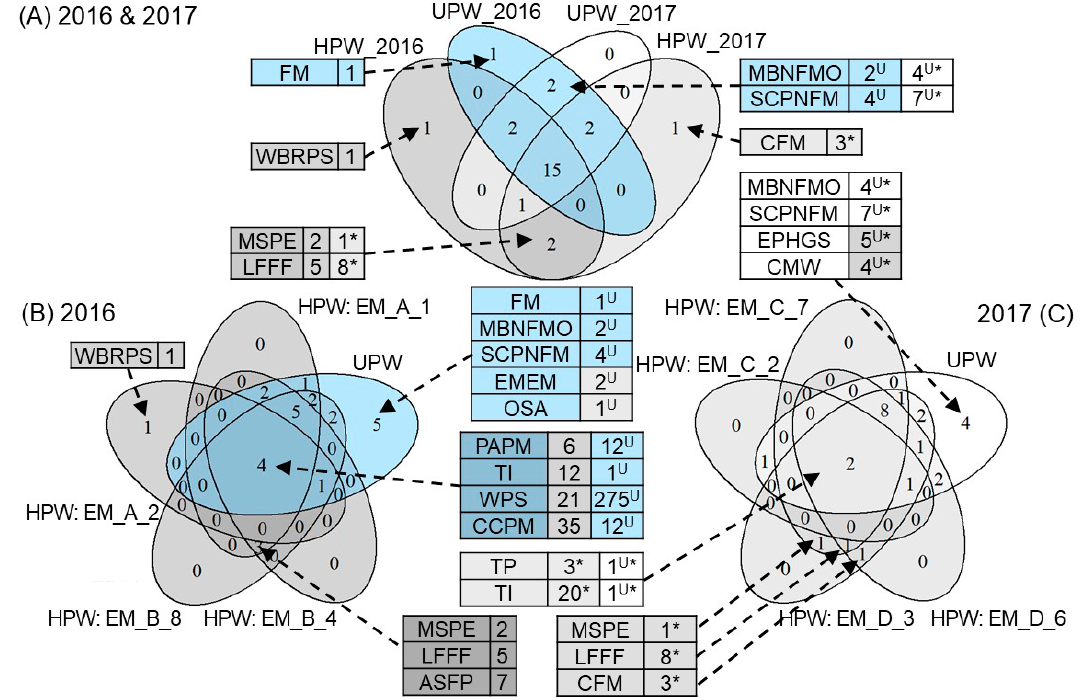
Figure 5. Economic activities and numbers of heavily polluted and unpolluted YRB wastewater-generating factory clusters calculated with different clustering algorithms in 2016 ( A ) and 2017 ( B ) (In figures, the acronyms represent the cluster names and the numbers represent the number of industrial classes in each cluster. In tables, the acronyms represent the industrial class names and the numbers represent the number of factories in each industry in each cluster. The superscript U represents the number of factories in the UPW (unpolluted wastewater) clusters and the superscript * represents the number of factories in the 2017 clusters).